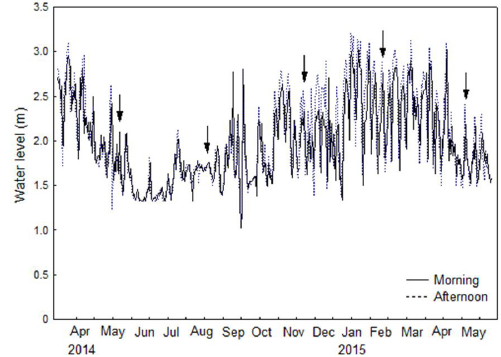
Figure 2. Daily variation in the water level of the Paraná River during the studied period (May/2014 to May/2015). Arrows indicate sampling days of the periphytic algal community.